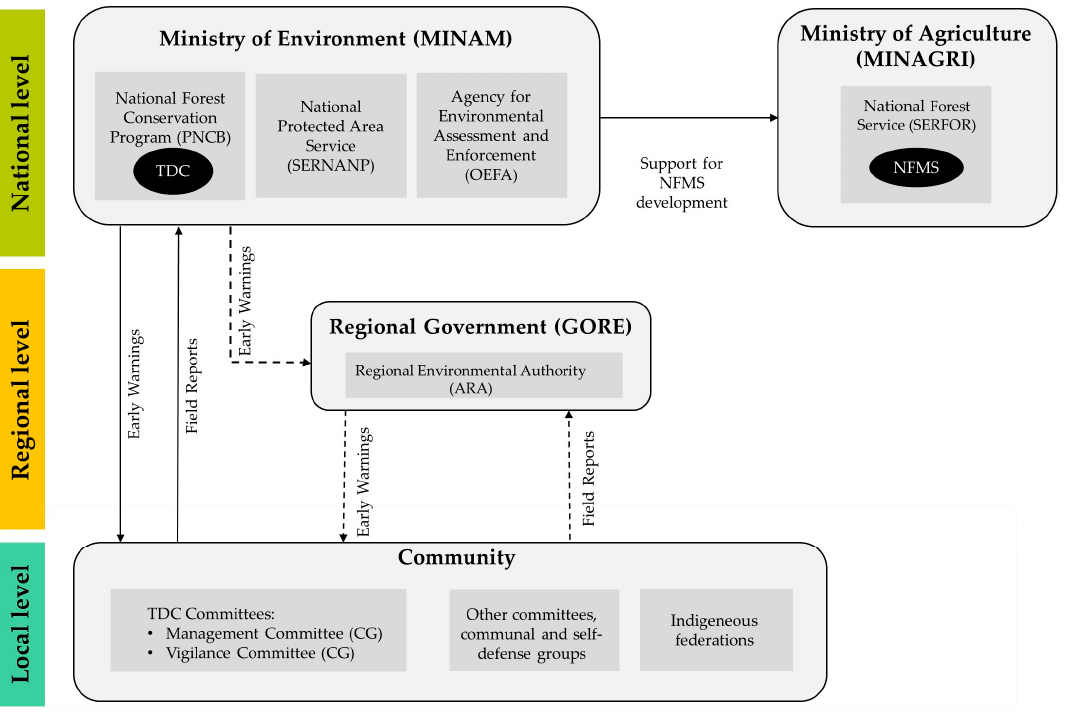
Figure 3. Multilevel institutional arrangements for forest monitoring in Peru.